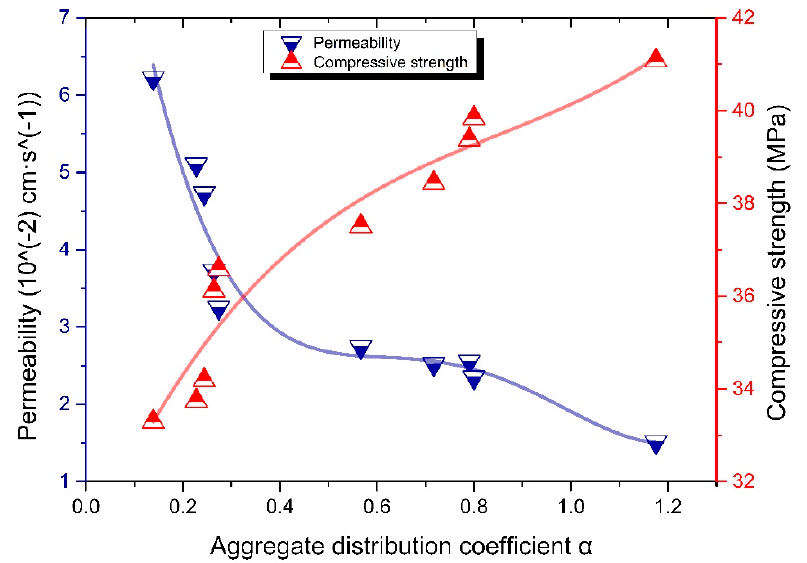
Figure 13. Relationship between α value of aggregate and compressive strength and water permeability of resin based permeable pavement materials.